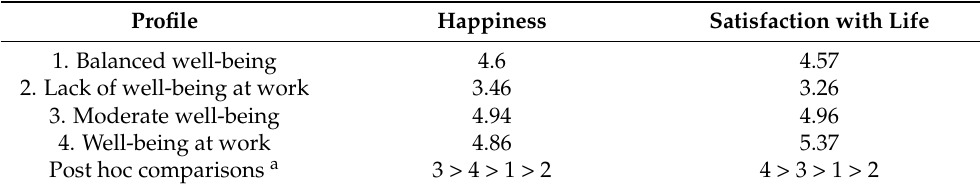
Table 6. Means associated with four-profiles model (SAS).